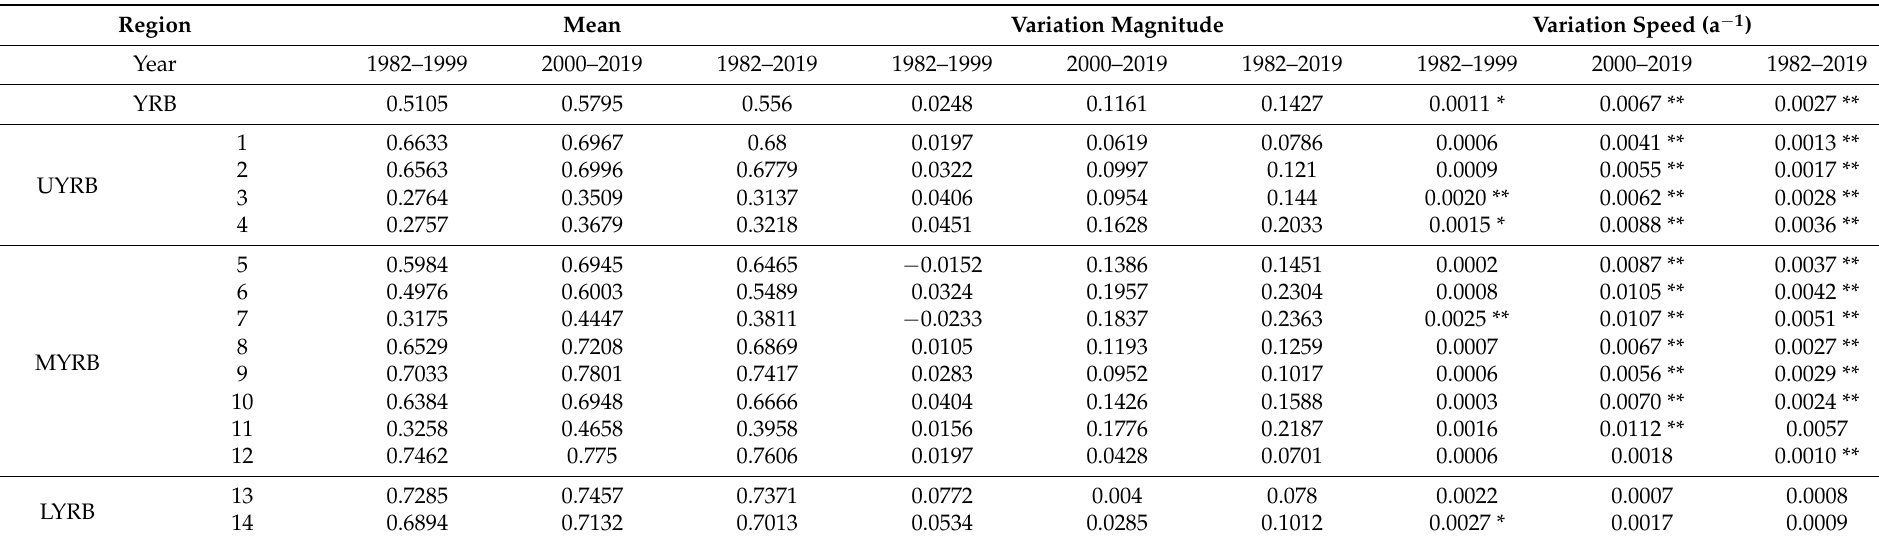
Table 2. Mean value of, the magnitude of change in, and the speed of change in the YRB and sub-basins in three periods. Region